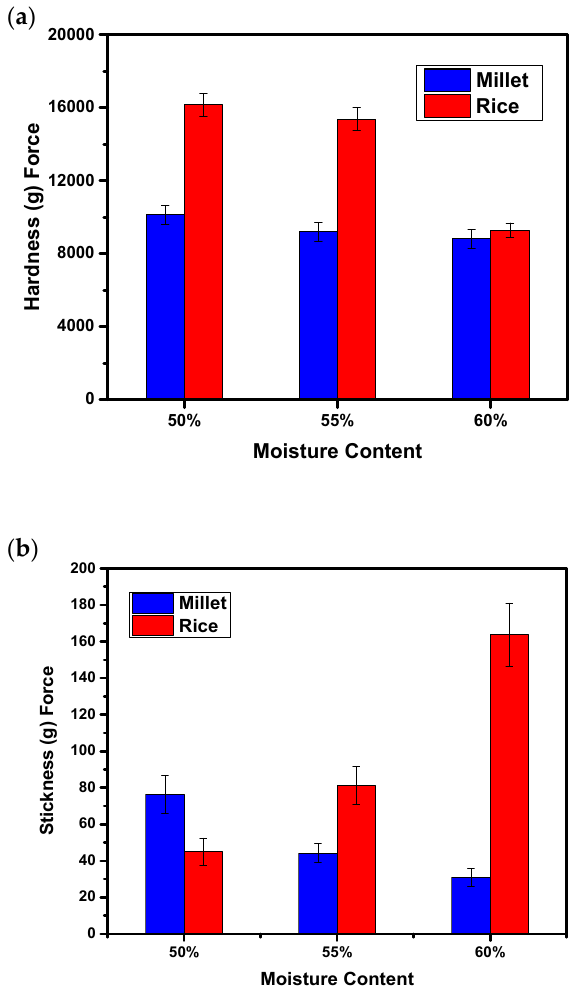
Figure 3. ( a ) Hardness and ( b ) stickiness levels of autoclaved parboiled rice and millet with di ff erent moisture contents (means and standard deviation were based on ten replicate